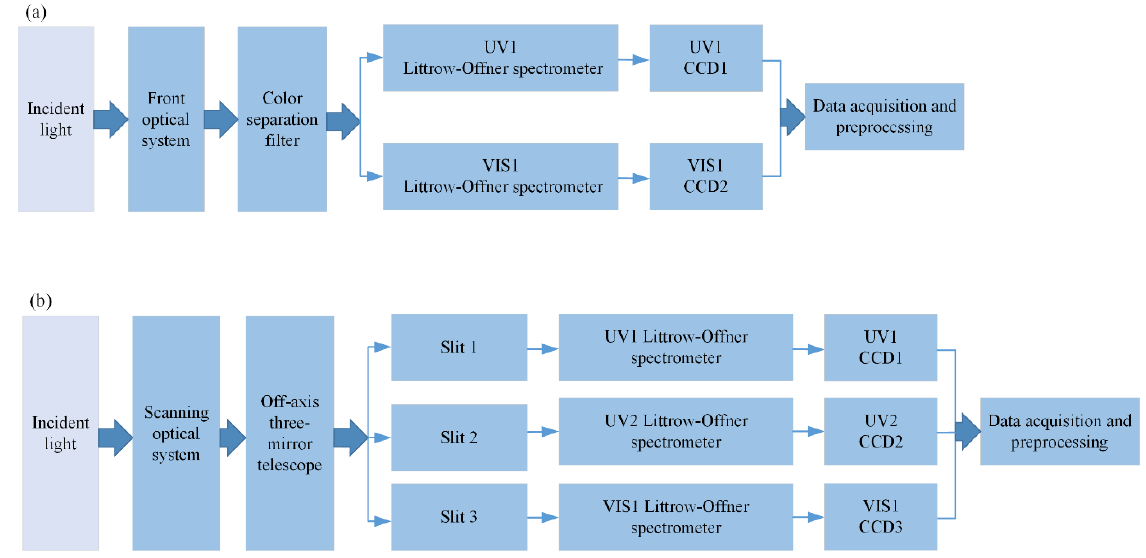
Figure 2. Optical system block diagram of the EMI-NL ( a ) nadir module and ( b ) limb